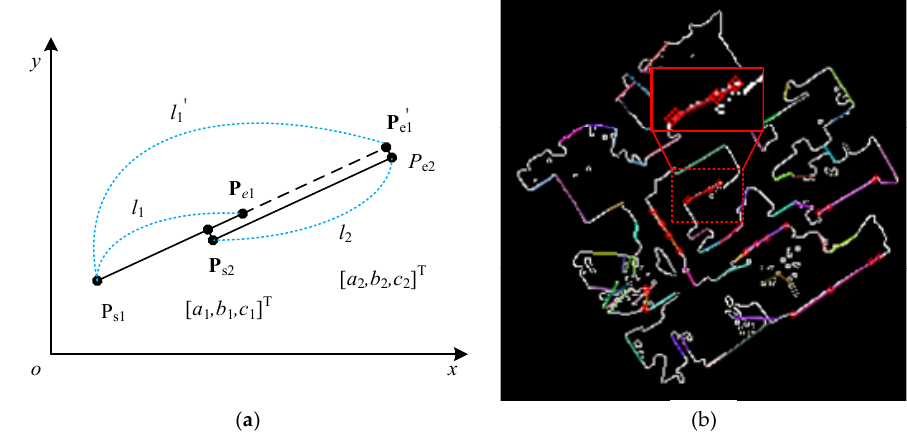
Figure 8. Line segments merging: ( a ) schematic diagram and ( b ) merging result based on the gird map. The points of line segment are 𝐏 (cid:2929) and 𝐏 (cid:2915) . The line parameters are [a, b, c] T . The line segment length is l. The projection point is 𝐏 (cid:2915)(cid:4593) . The recalculated line segment length is l’.